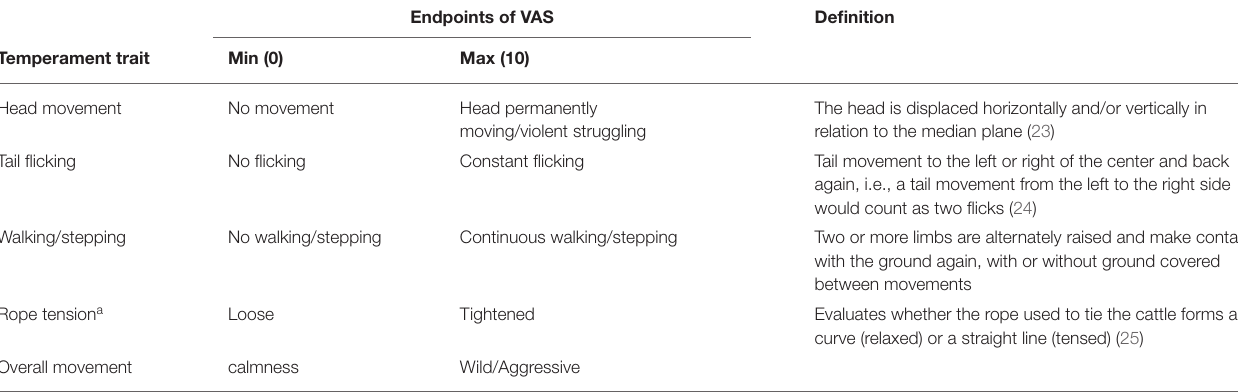
TABLE 1 | Definition of temperament traits and visual analog scale (VAS).